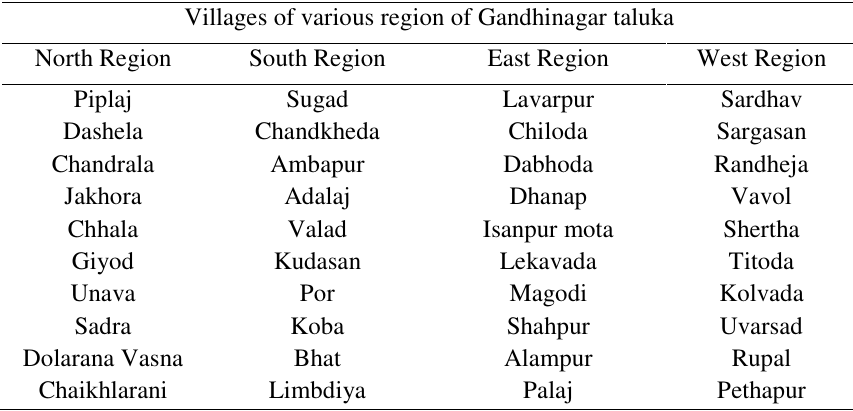
Table 1. Name of villages of Gandhinagar taluka used for water sampling Villages of various region of Gandhinagar taluka North Region South Region East